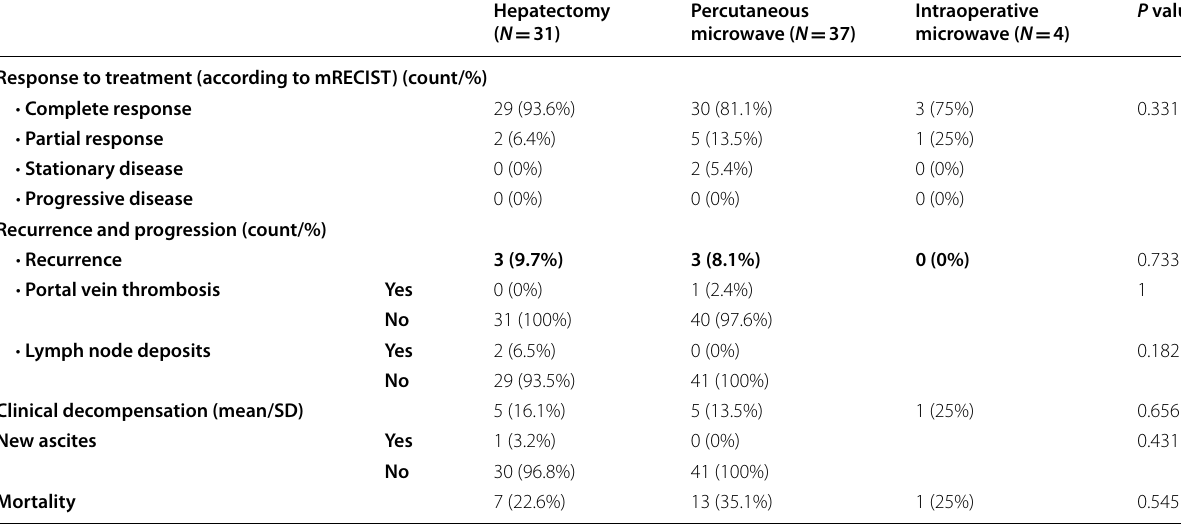
Table 2 Follow-up and the fate of managed patients